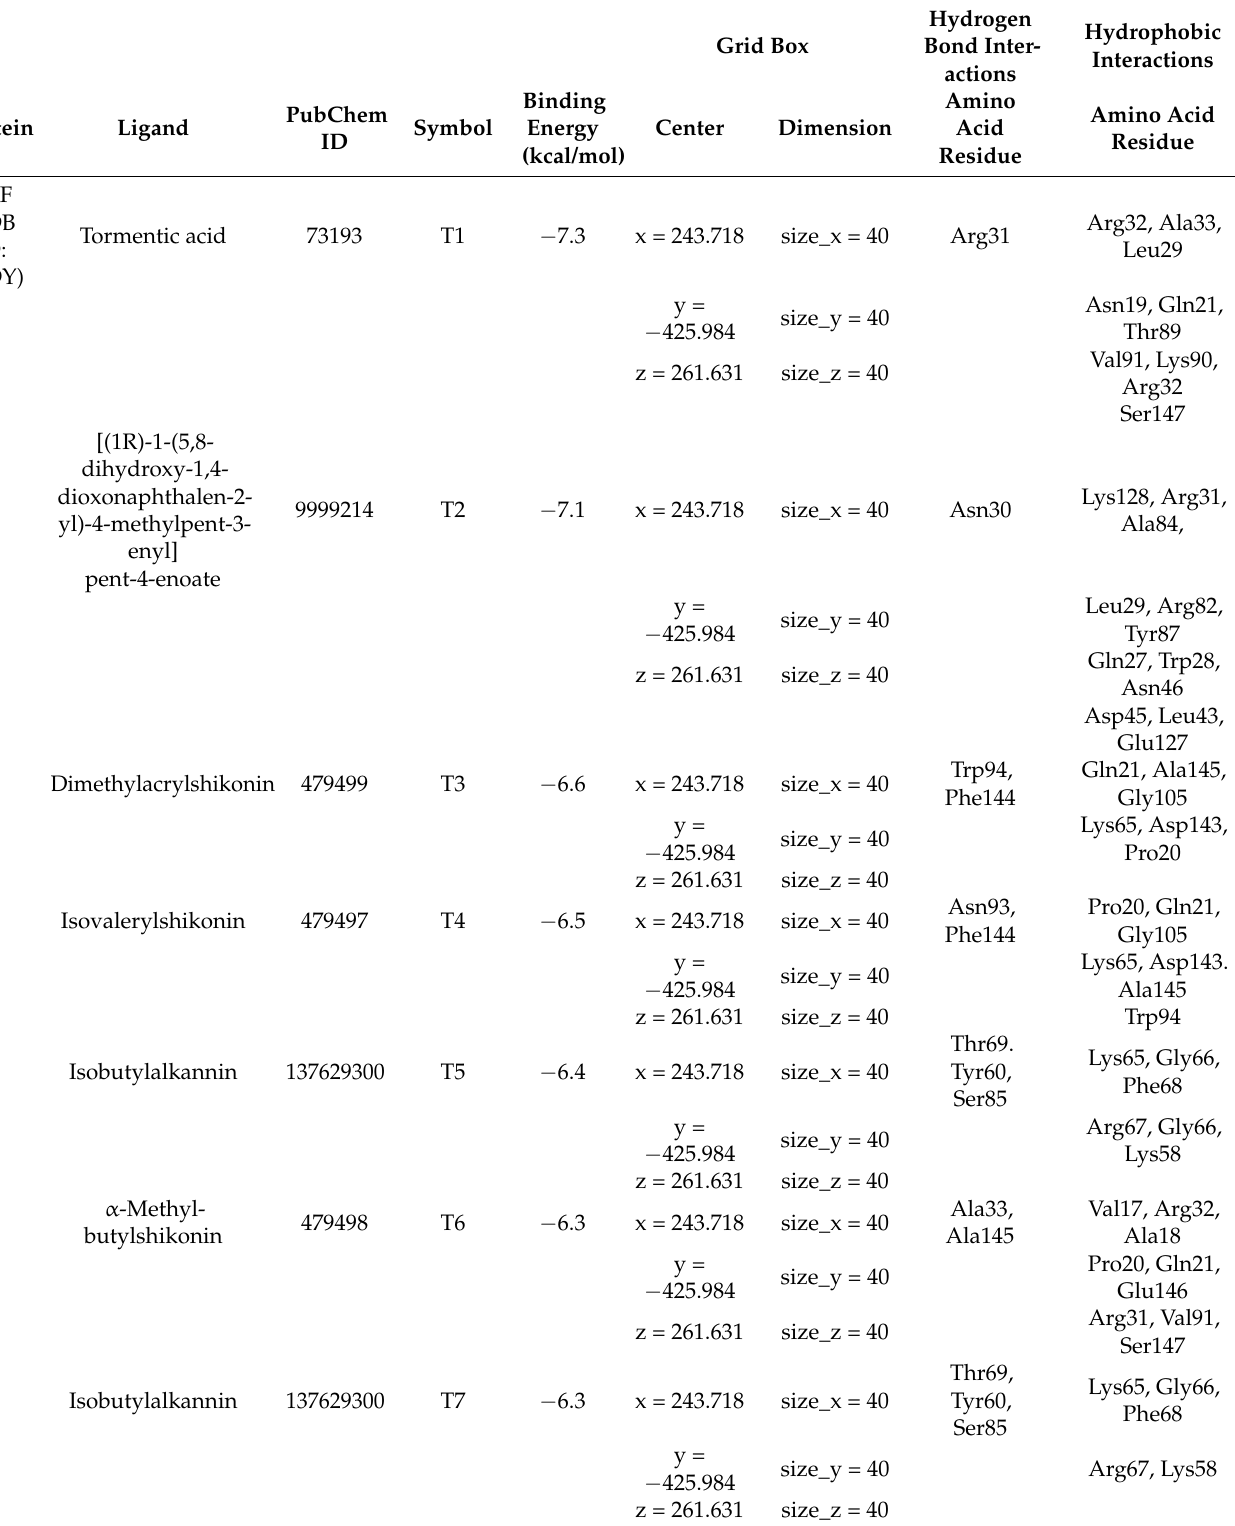
Table 6. Binding energy of potential active compounds on TNF (PDB ID: